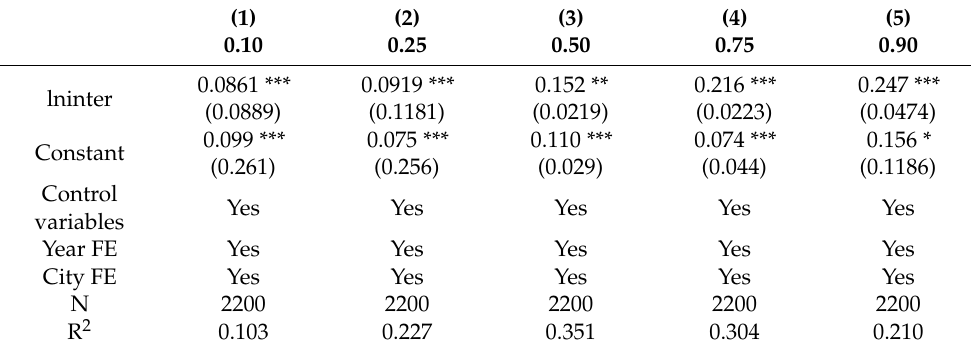
Table 3. Quantile